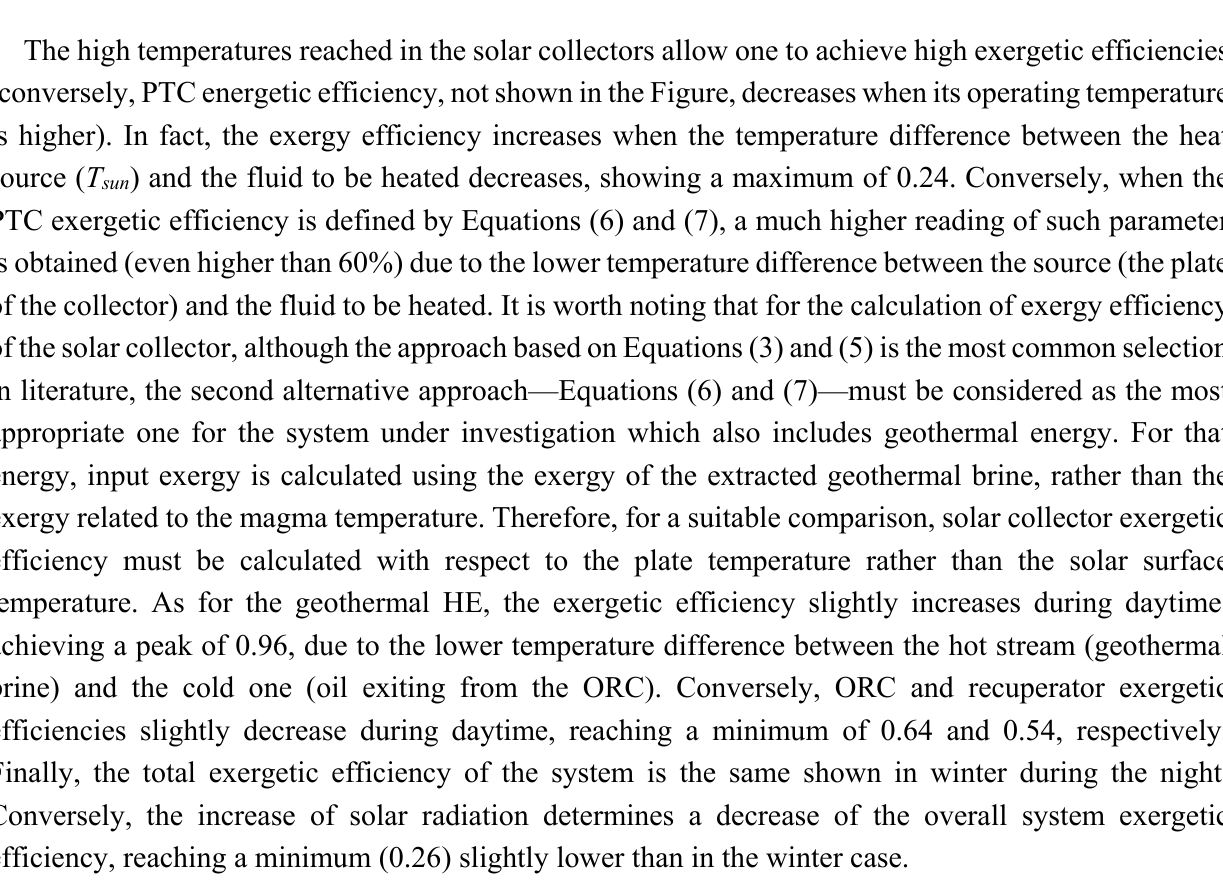
Figure 9. Exergy efficiencies in a summer